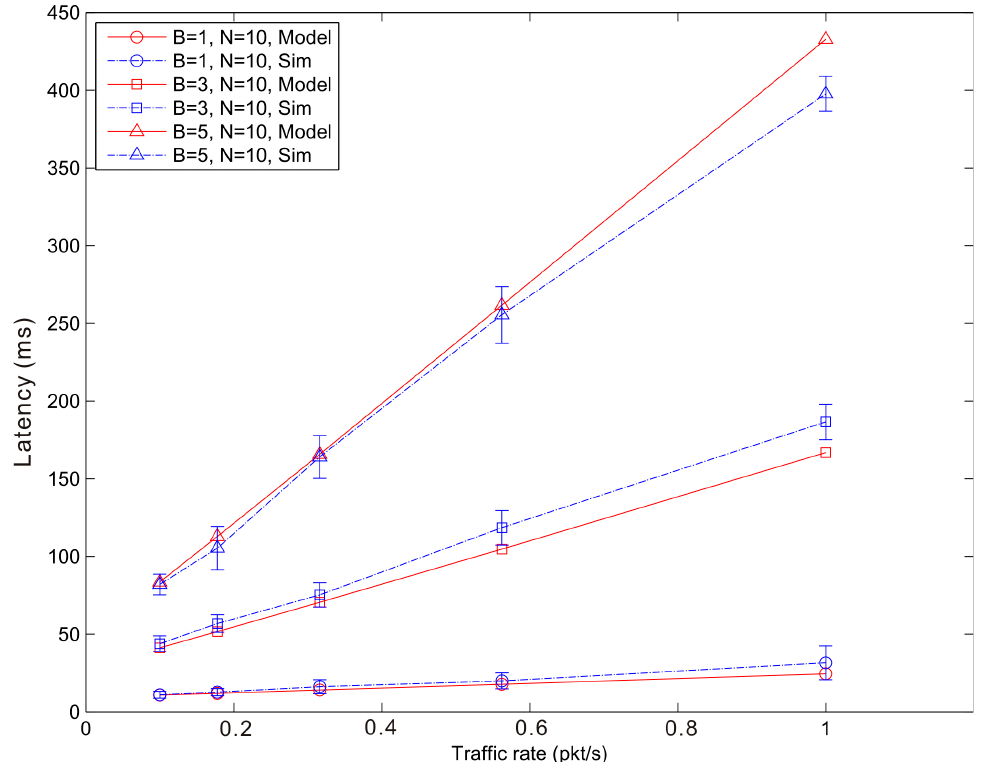
Figure 14. Blockwise Latency versus traffic rate for a star topology network composed by 10 nodes.